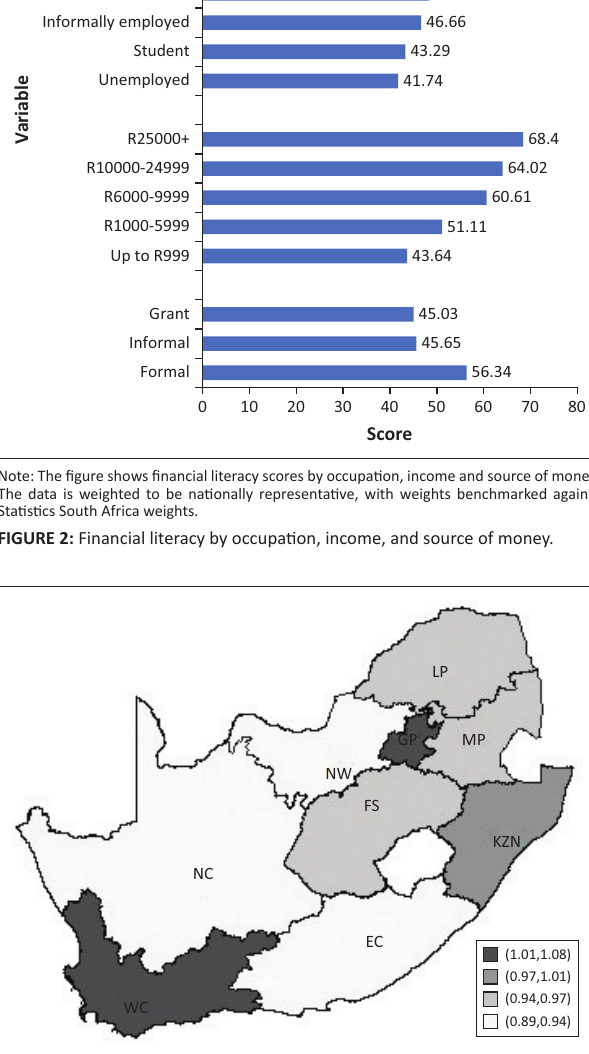
Note: The figure shows the relative distribution of financial literacy by province. The darker shades reflect higher financial literacy scores and they fade as the scores fall relative to the national average. FIGURE 3: Provincial financial literacy relative to the national